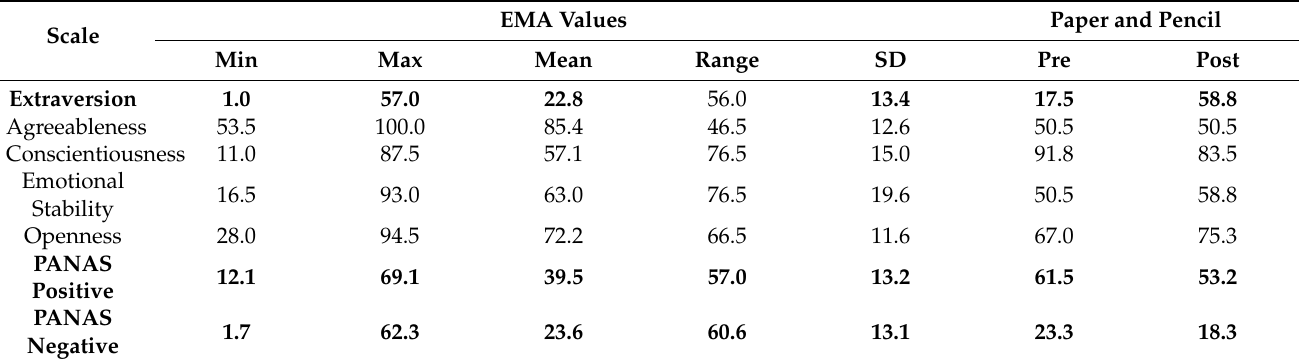
Table 2. Personality and affect variability: Alice ( n = 102